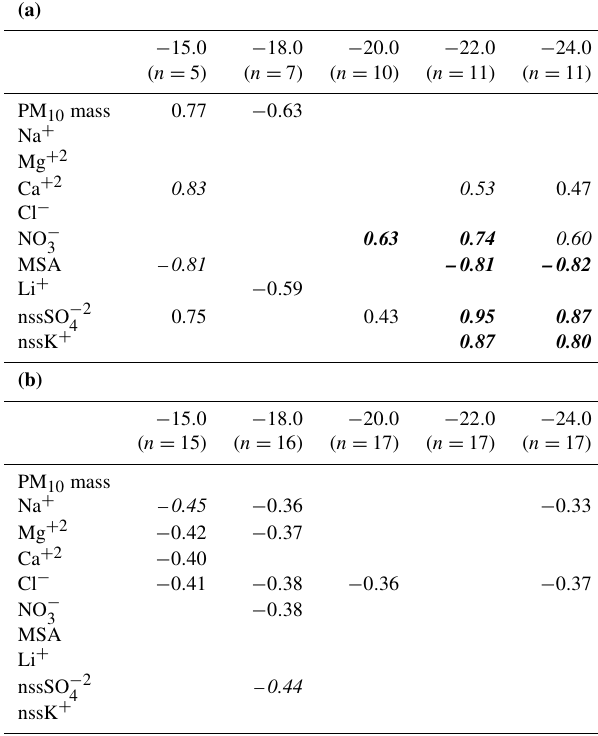
gions in the seawaters surrounding the Svalbard archipelago (time lag 6 d), close to the Greenland coast (time lags 14